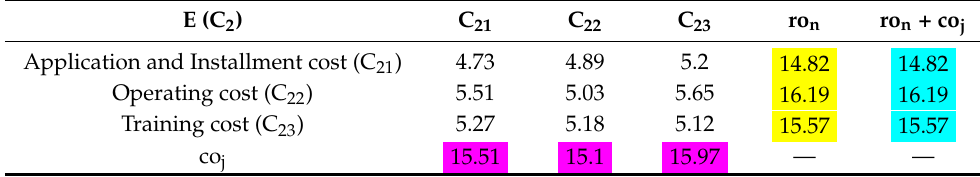
Table 17. Total direct influence matrix T between Economical (C 2 ) sub-criteria.